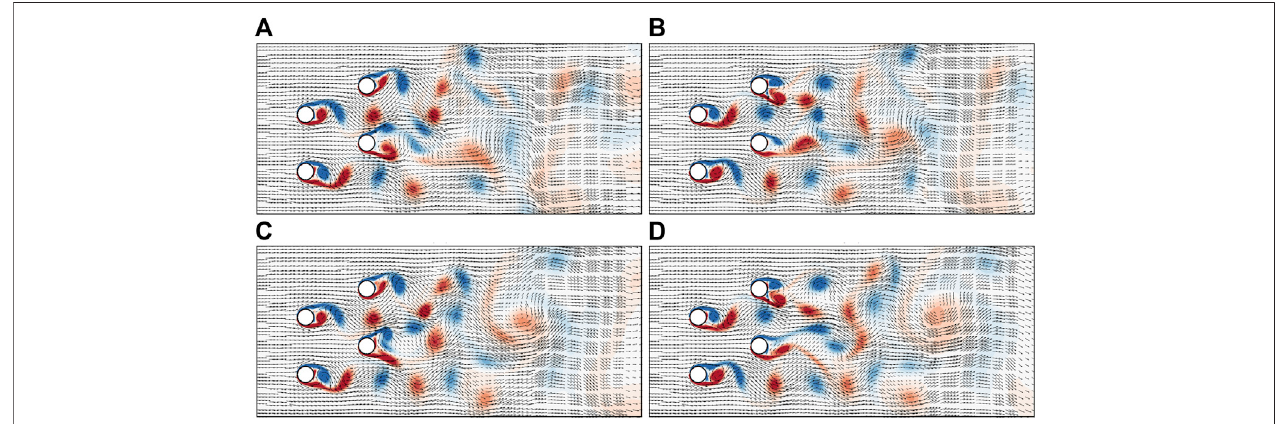
FIGURE4| Vorticitycontourand fl owvelocitydistributionbehindthecylindersatfourdifferentinstants: (A) tU / L =22.7, (B) tU / L =24.7, (C) tU / L =26.7,and (D) tU / L = 28.7.